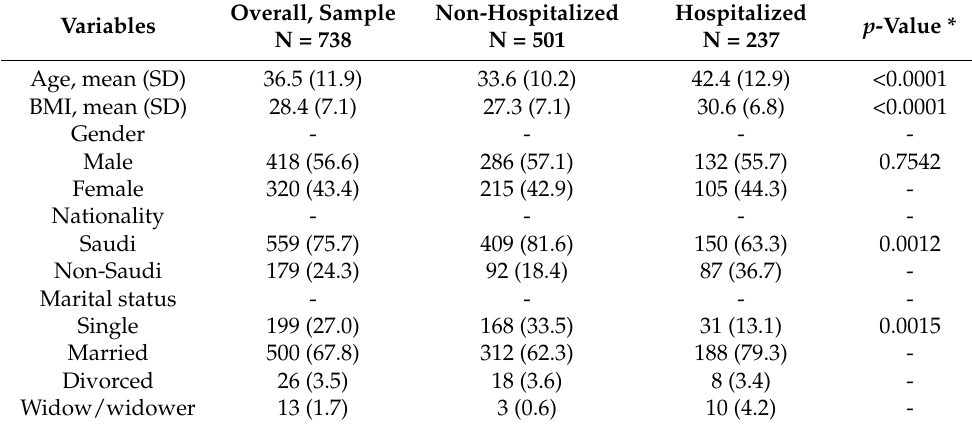
Table 1. Patient demographics †